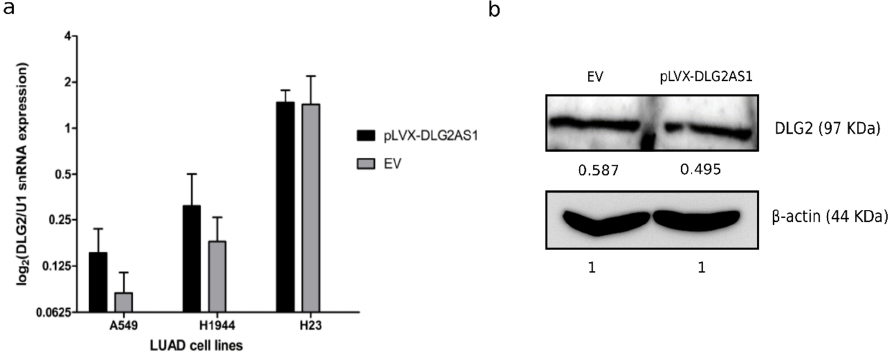
Figure A2. DLG2-AS1 is not a cis-regulator of DLG2 expression. ( a ) RNA expression levels of DLG2 were una ff ected after DLG2-AS1 overexpression (pLVX-DLG2AS1) compared to empty vector transfection (EV). Results from RT-qPCR were normalized to expression of the reference gene U1 snRNA. ( b ) Protein levels of human DLG2 did not change upon transfection with pLVX-DLG2AS1 compared to EV in two independent Western blot experiments (relative pLVX-DLG2AS1 / EV densitometry measure mean = 0.984 ± 0.199, p = 0.929). Uncropped WB images are available at the Supplementary Material zip